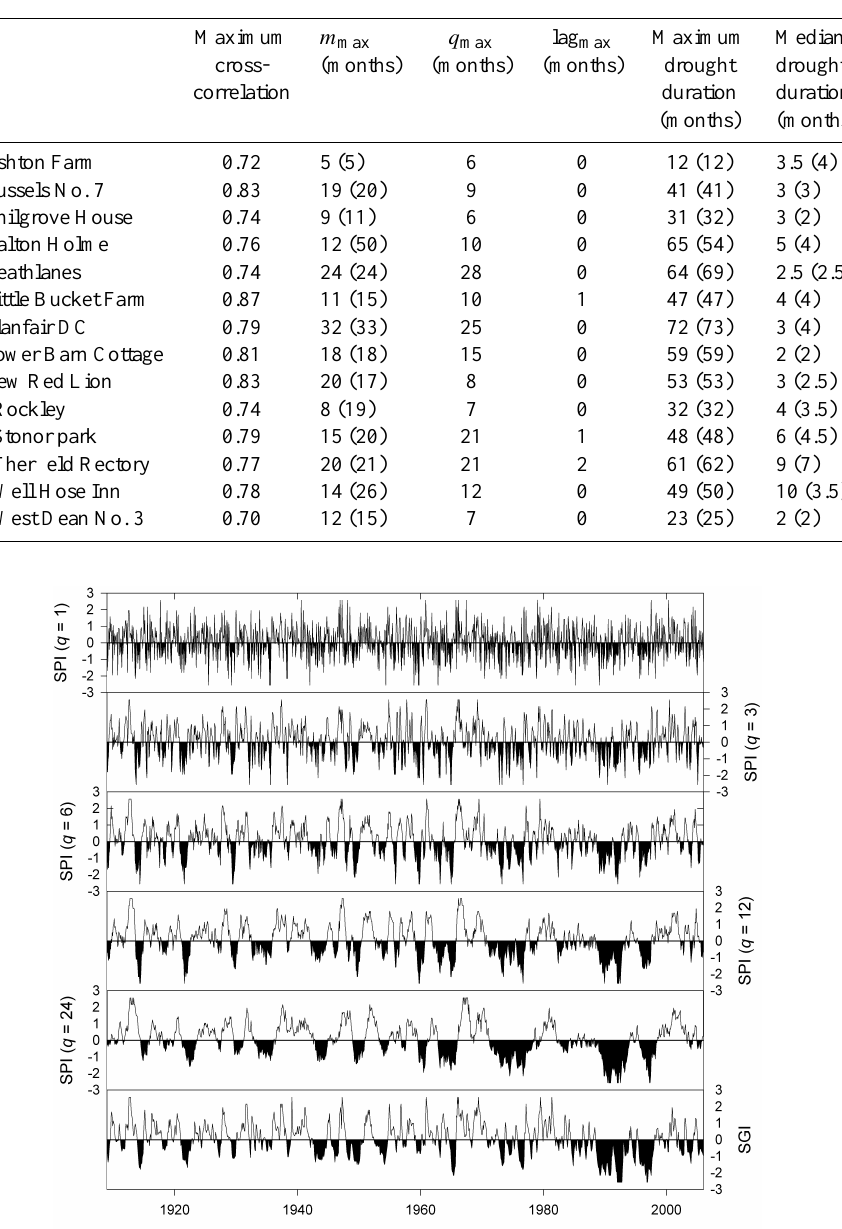
Table 2. Value of the maximum cross-correlation between SPI and SGI, SGI autocorrelation range ( m max ), the accumulation period asso- ciated with maximum cross-correlation between SPI and SGI ( q max ), the lag associated with maximum cross-correlation between SPI and SGI (lag max ), and maximum and median drought duration at each site. Values in parentheses are based on a 29yr record from 1977 to end of 2005 and are used in Fig. 12.